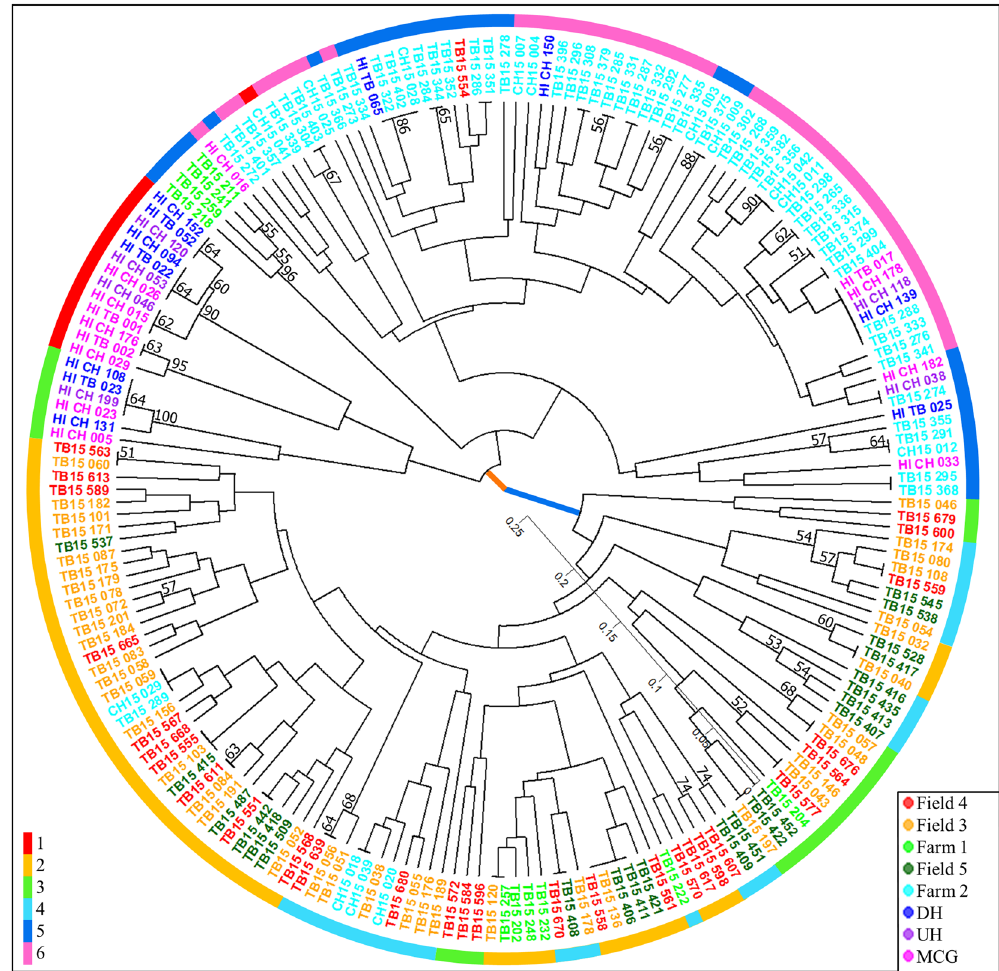
Figure 6. UPGMA dendrogram of Cercospora beticola isolates collected in 2015 from New York (Farm 1, Farm 2, Field 3, Field 4 and Field 5) and Hawaii (MCG = Manoa community garden, UH = University of Hawaii organic garden, and DH = Diamond Head community garden) based on Bruvo’s distance. Bootstrap support values greater than 50 are shown above the branches. The thick orange and blue branches denote the two clusters detected through Bayesian clustering method implemented in STRUCTURE. The colour of the isolates correspond to the field/community garden they belong as indicated in the right-hand-side legend. The colour of the outer ring corresponds to the six clusters detected by DAPC analysis as shown in the left-hand-side legend and Fig.